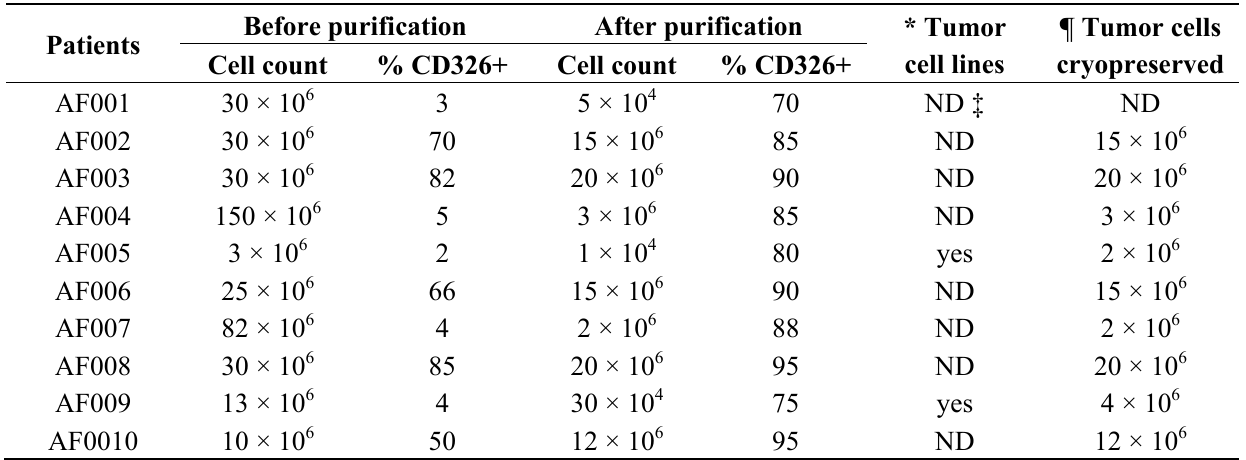
Table 3. Primary ovarian tumor cells cultures established from ascitic